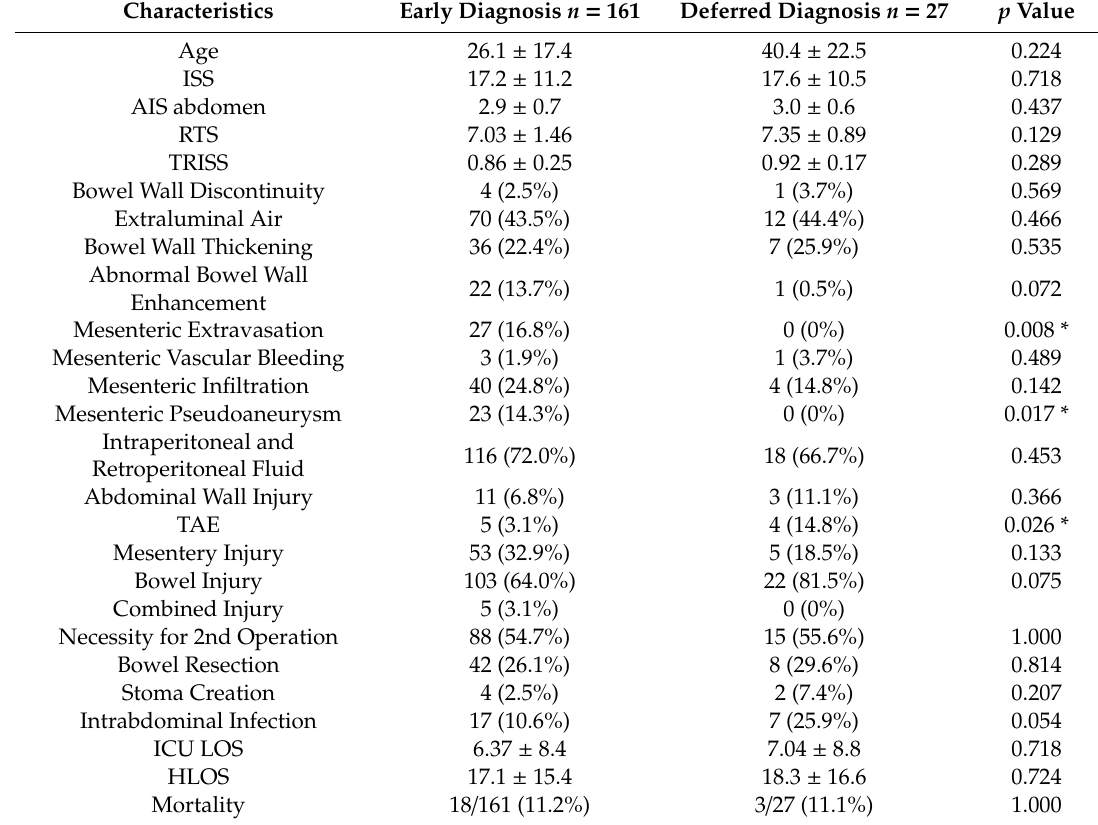
Table 2. The comparison of early and deferred diagnosis